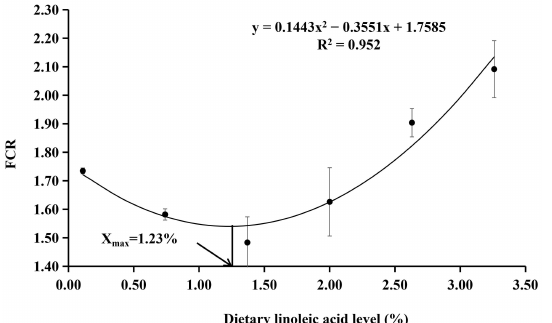
Figure 2. Quadratic regression analysis of FCR with dietary LA levels in coho salmon Oncorhynchus kisutch alevins. Estimated dietary LA requirement of SGR is 1.23%. Each point represents the mean of three replicates.